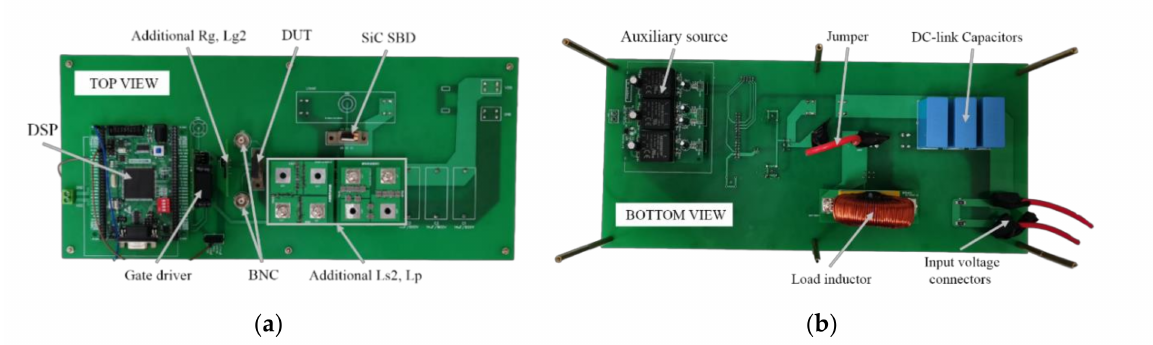
Figure 10. Double-pulse-test setup with varied elements. ( a ) Top view. ( b ) Bottom view.